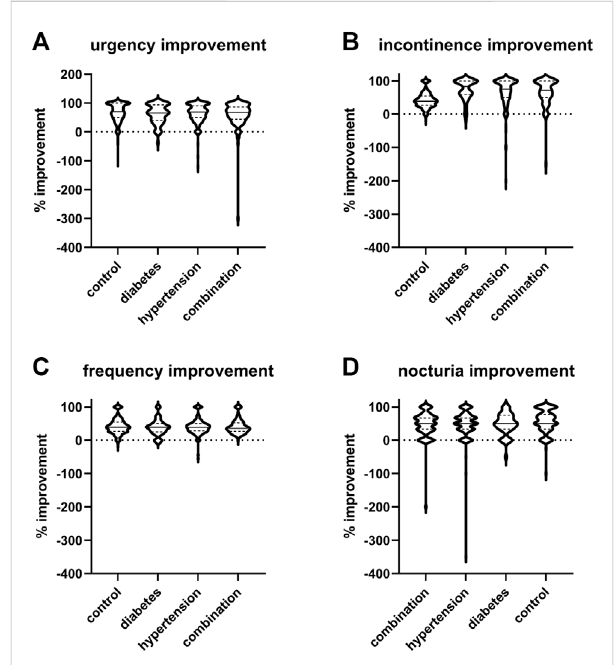
FIGURE 4 Violin plots of % changes in study II in number of (A) urgency, (B) incontinence, (C) frequency, and (D) nocturia episodes per 24 h. Median and interquartile ranges are indicated by the horizontal solid and dashed lines, respectively, within each plot. Note that only subjectwithapathologicalvalueatbaselinewereincludedaverysmall number of subjects exhibited a worsening, indicated here as negative value.